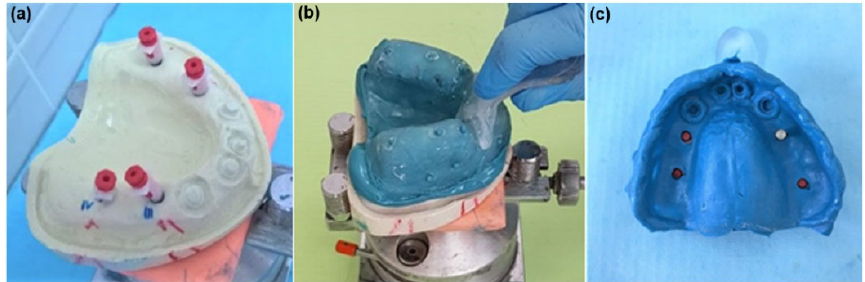
Figure 6. Indirect (closed) click impression method: ( a ) mounted transfers, ( b ) polyether impressions, and ( c ) addition silicone impression after separation.